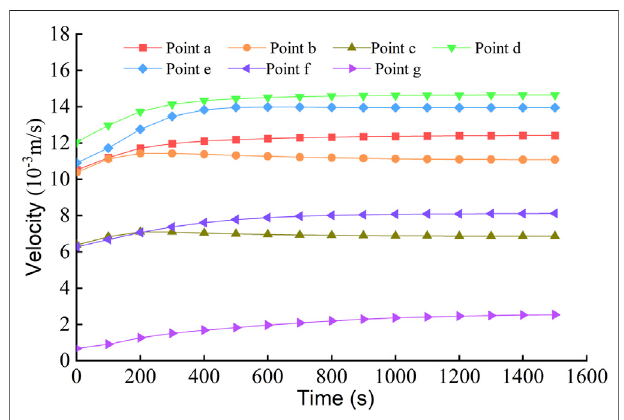
FIGURE 12 | Flow velocity evolution at typical